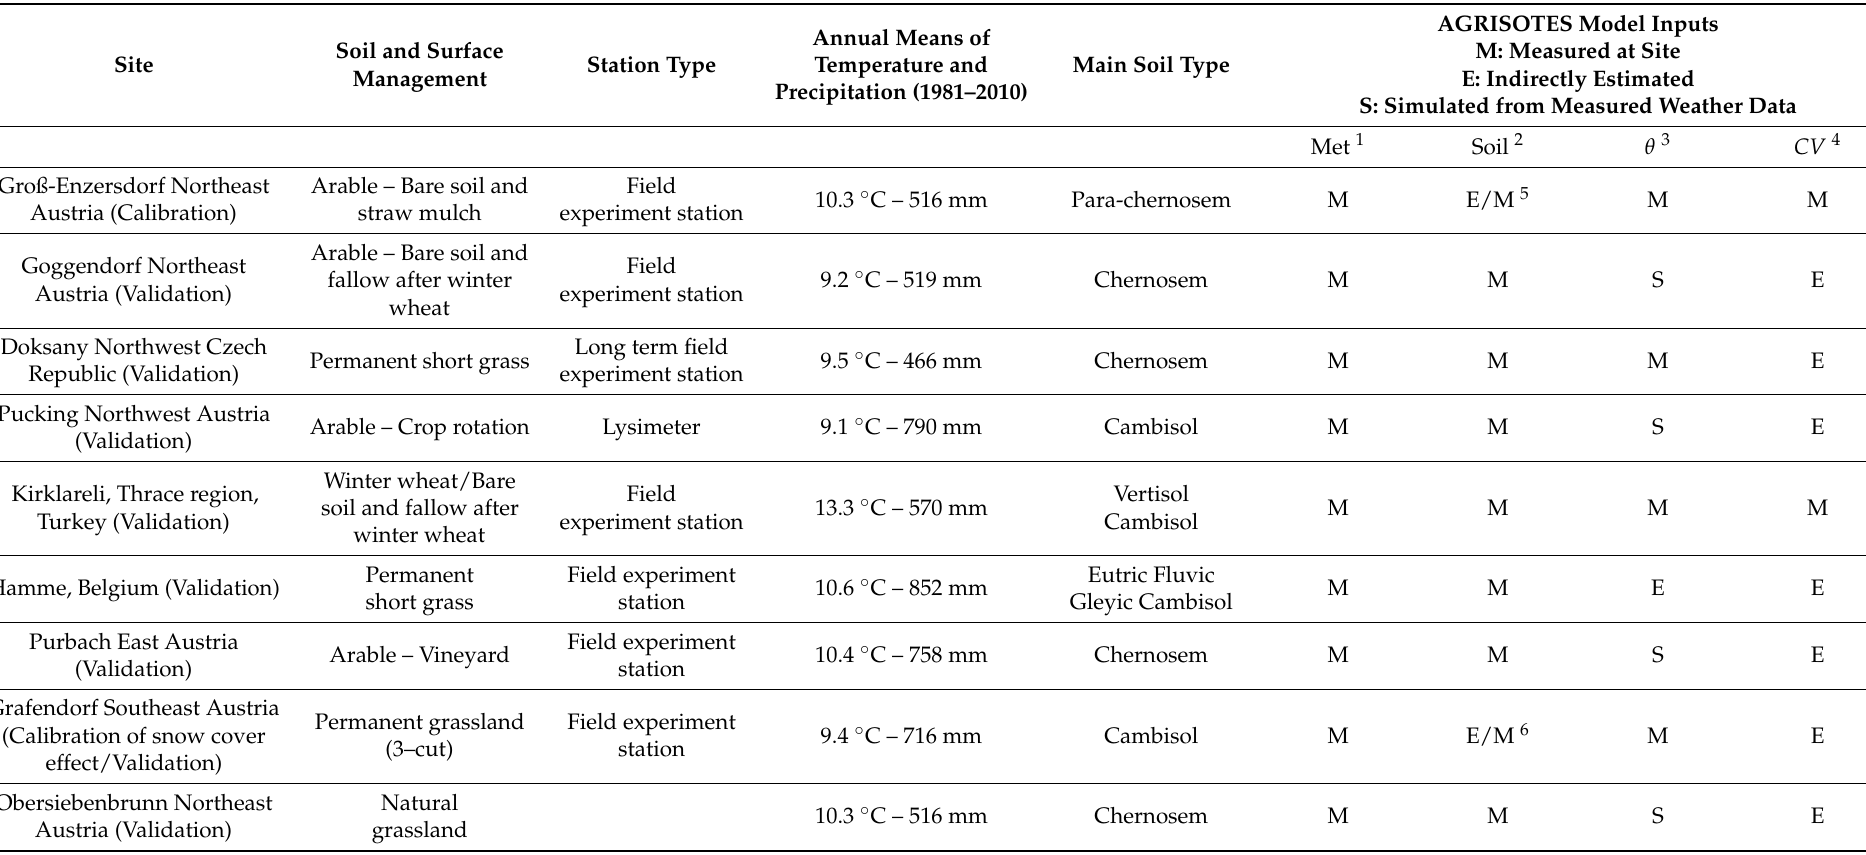
Table 1. Main characteristics of site conditions used for generating representative inputs for the AGRIcultural SOil TEmperature Simulation (AGRISOTES) model for the calibration and validation periods (all sites characterized by no or only negligible slope inclination and no shading from larger